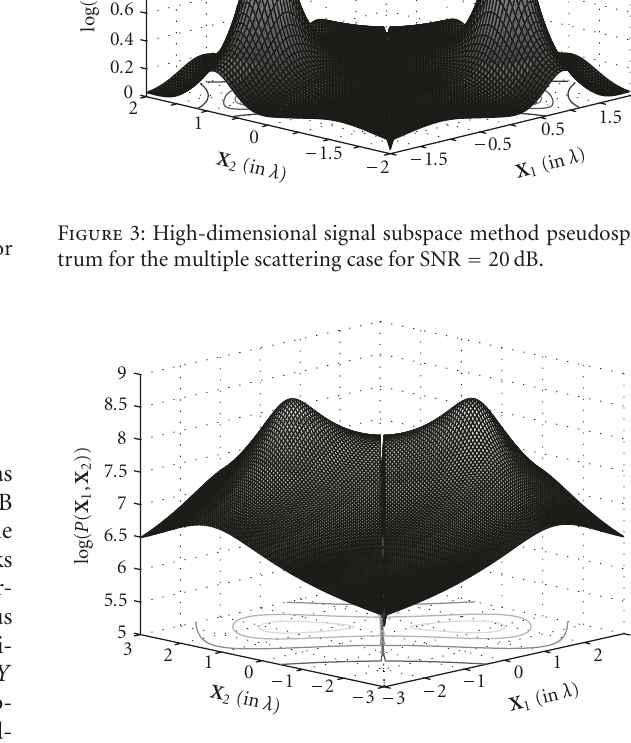
Figure 4: High-dimensional pseudospectrum for two antennas de- tecting two Born-approximated targets located at X 1 = ( X 1 = − 1, Y = − 6) and X = ( X = 1, Y = − 6) for SNR = 1 2 2 2